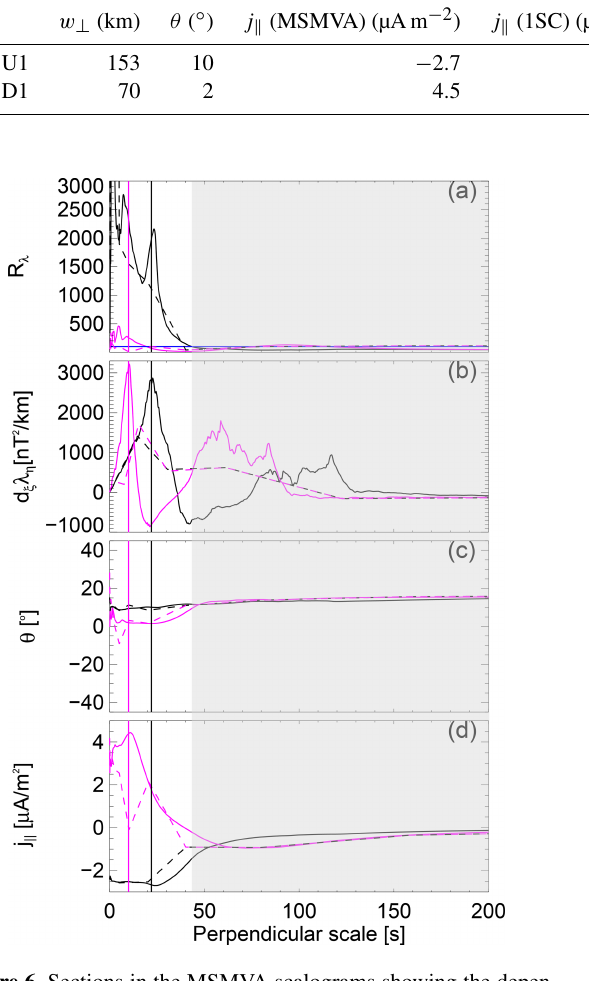
pected from the (cid:49) B profile. The gray shaded area in Fig. 6 shows the range of scales for which R λ is below an arbi- trary reference level of 100. This indicates the possibility of cleaning MSMVA quantities based on the planarity